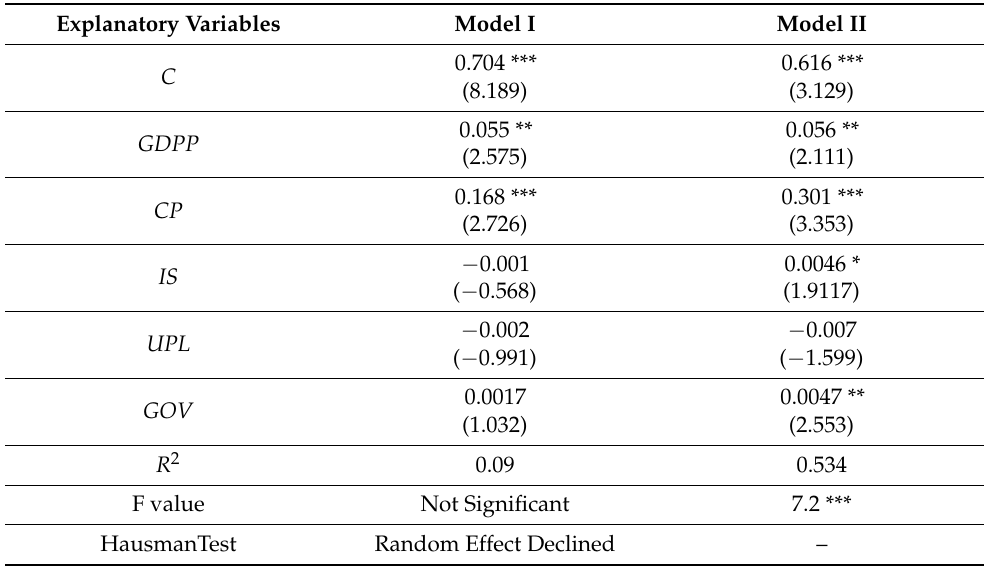
Table 6. Panel data model on regression analysis of explanatory variables with land efficiency